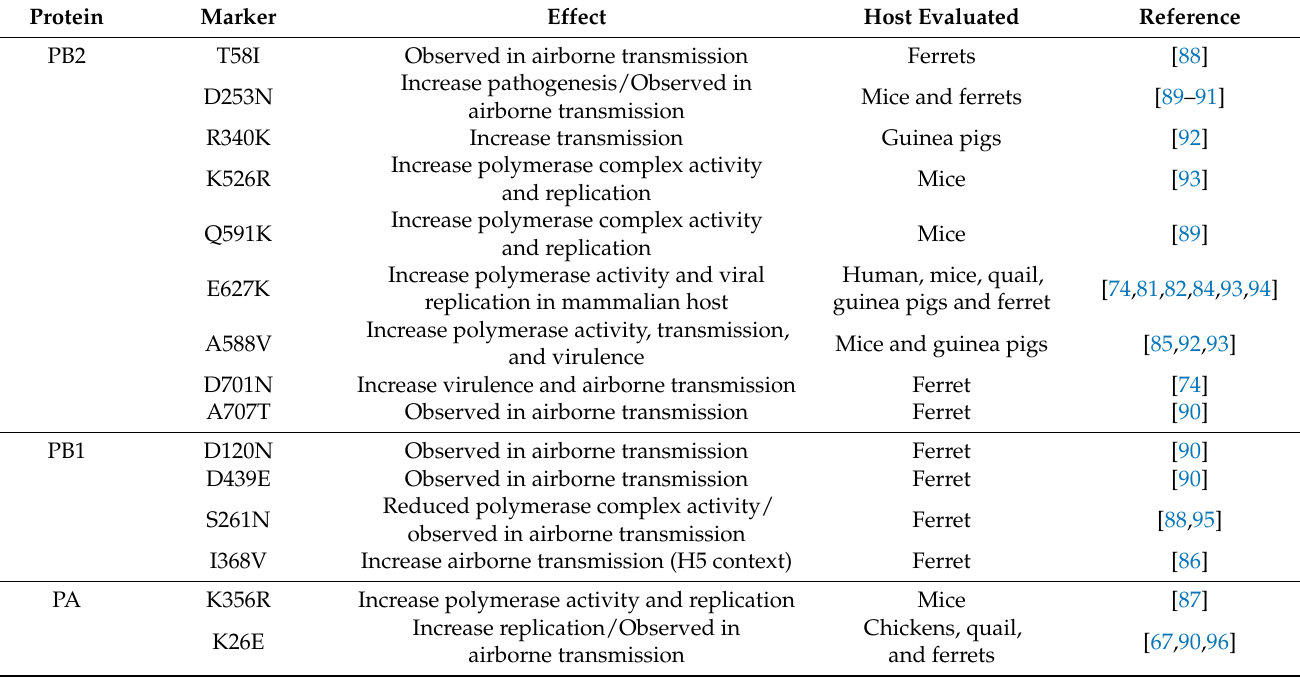
Table 1. Molecular markers associated with adaptation and transmission of H9N2 IAV in mammalian host. Protein Marker Effect Host Evaluated